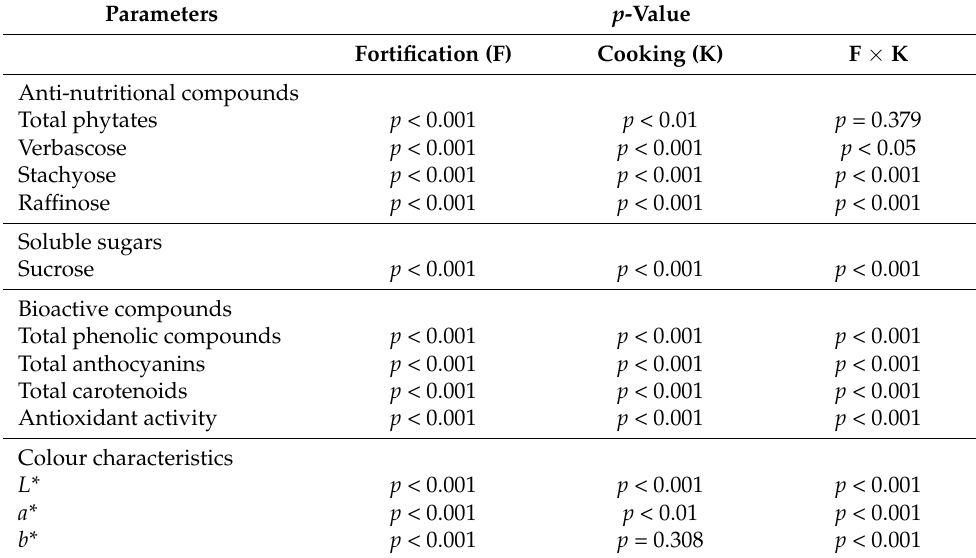
Table 4. Statistic influence, analysed by two-way ANOVA, of fortification (F) and cooking (K) factors and their interaction (K × F) on anti-nutritional and bioactive compounds, and colour characteristics of GF fresh pasta. Fortification consisted in the addition of Apulian black or kabuli chickpea